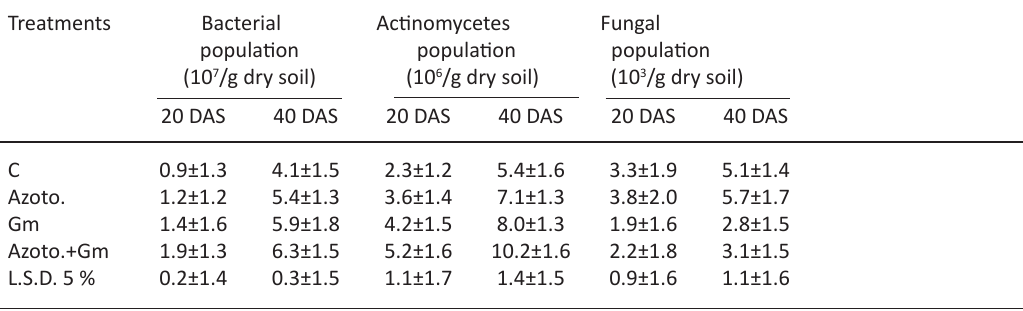
Table 2. Microbial population of onion rhizosphere as influenced by inoculation with Glomus moseae and Azotobacter chroococcum , 20 and 40 days after planting (DAS) Treatments Bacterial Actinomycetes Fungal population population population (10 7 /g dry soil)